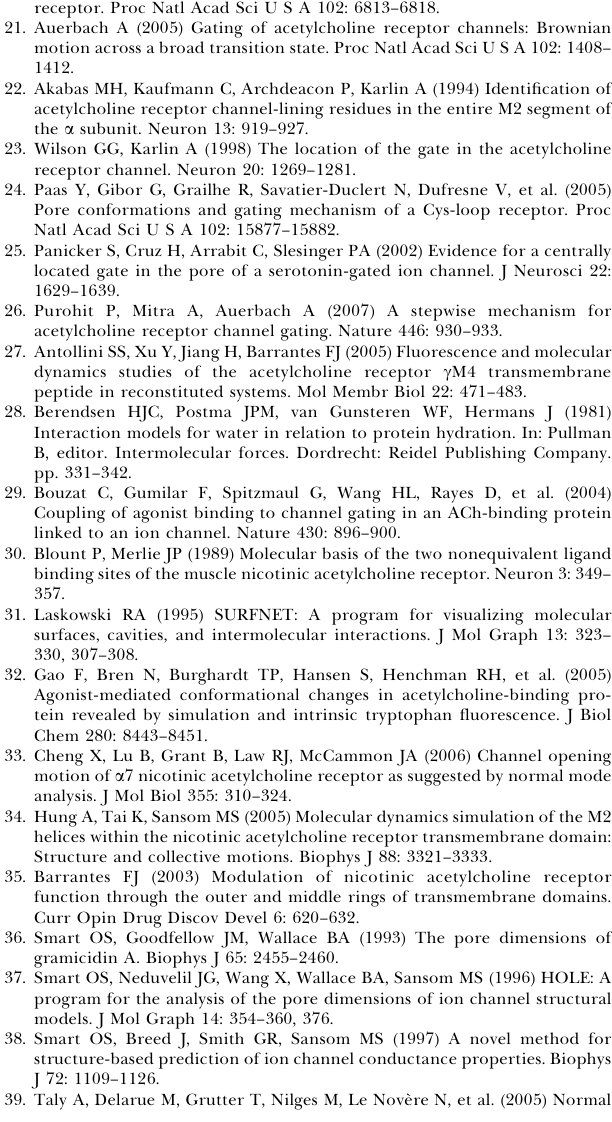
Figure S4. Angular Displacements of the Pore-Facing Rings in the M2 Helices Relative to the EC Domain with Respect to Their Starting